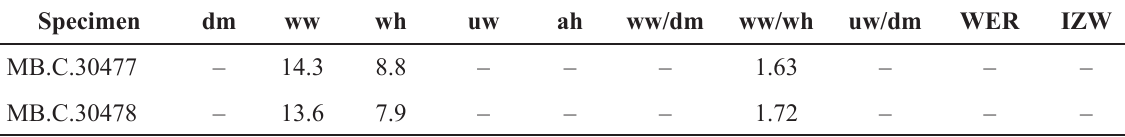
Table 13. Conch dimensions (in mm) and ratios of Trilobitoceras peculiaris gen. et sp. nov.